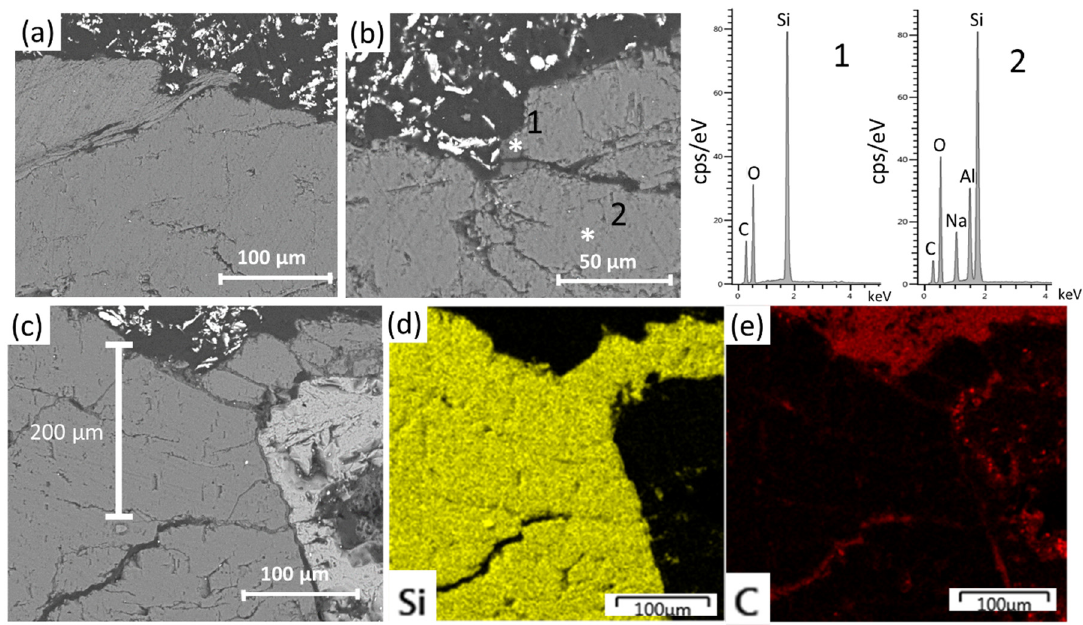
Figure 8. SEM micrographs of the polished cross sections from the surfaces treated with consolidant products without TiO 2 nanoparticles. ( a , b ): Estel 1000-treated surface, (b) is accompanied with the EDS spectra. ( c – e ): Nano Estel-treated surface. ( d ) Si compositional map. ( e ) C compositional map.